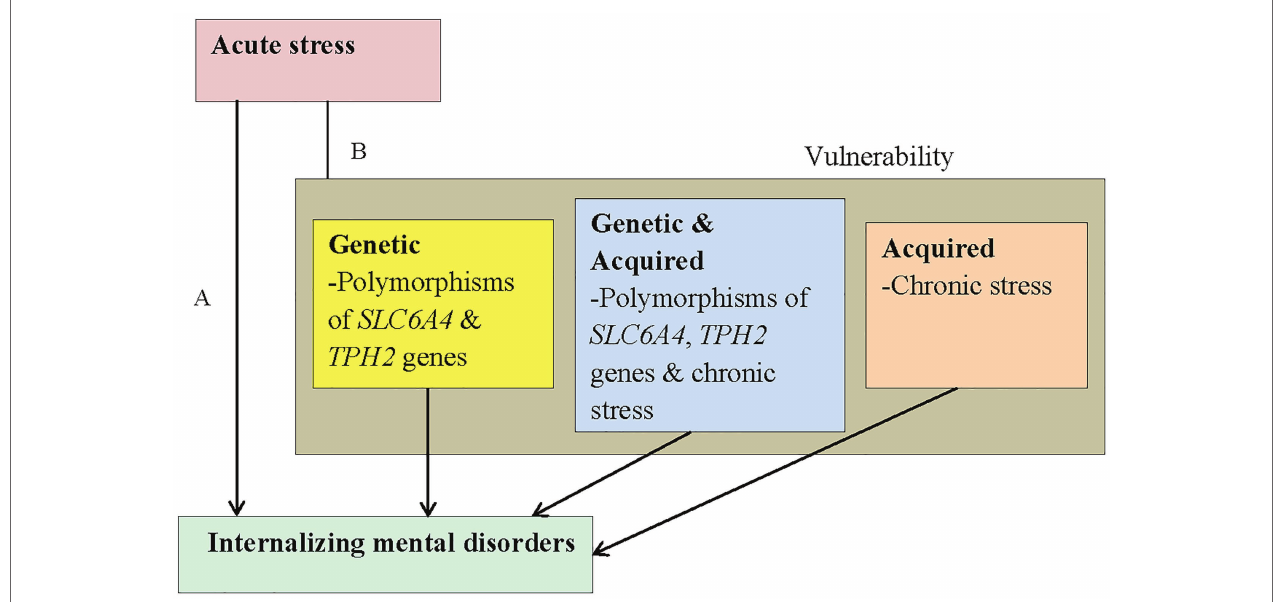
FIGURE 1 | The conceptual framework is adapted from the diathesis-stress model for depression (Monroe and Simons, 1991). The aim of the present study was to investigate the association between acute stress and IMDs (A) . We postulated that acute stress would interact with vulnerability factors [ B ; genetic (yellow block), acquired (pink block), or both (blue block)] to increase the risk for IMDs. SLC6A4, serotonin transporter gene; TPH2, tryptophan hydroxylase 2